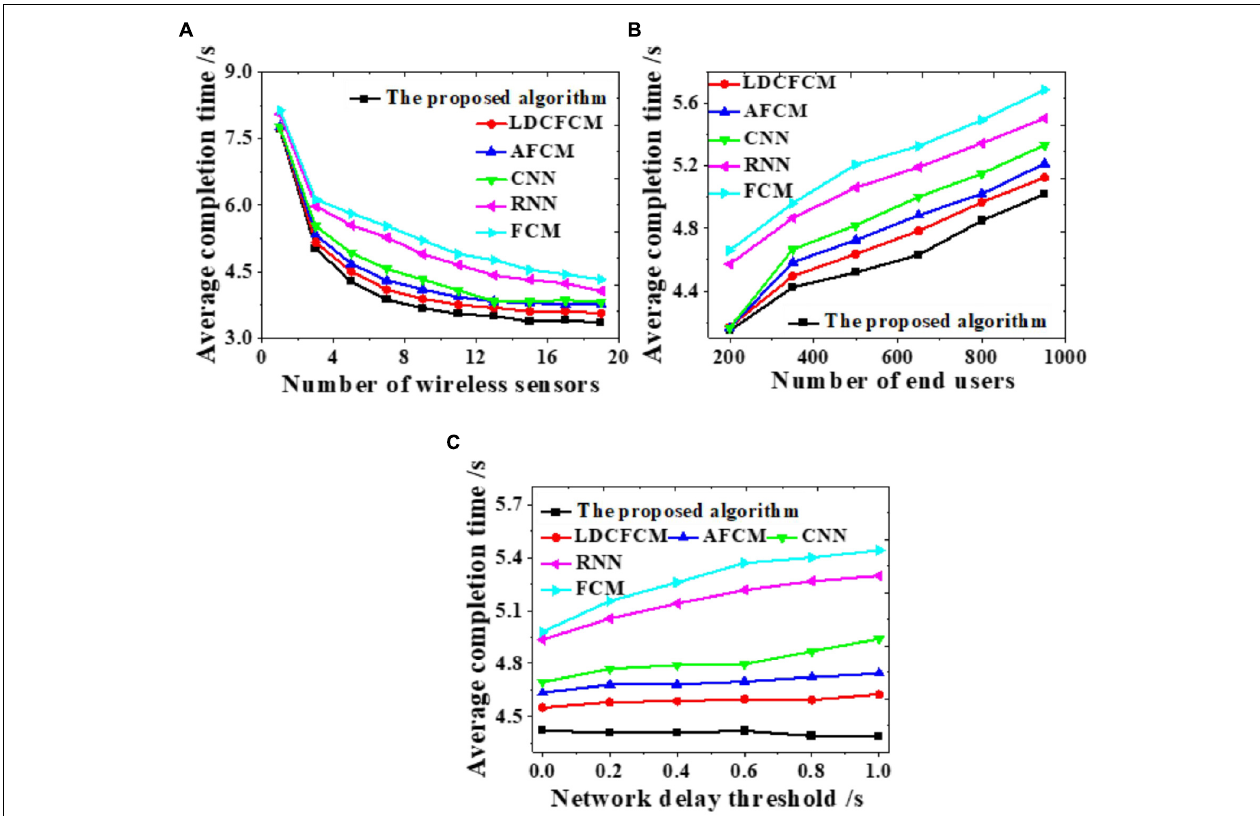
FIGURE 7 | Influences on the average completion time under different factors. (A) Number of wireless sensors. (B) Number of end-users. (C) Network delay